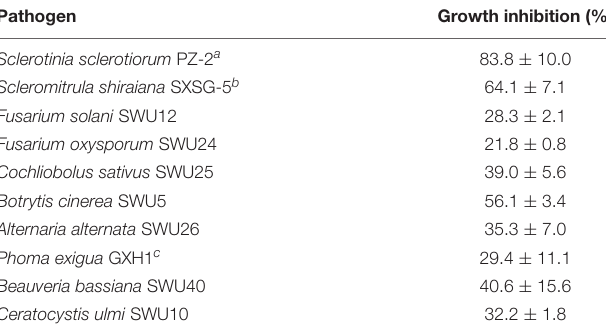
TABLE 4 | Inhibitory activities of cell-free supernatant of B. megaterium HGS7 on phytopathogens.